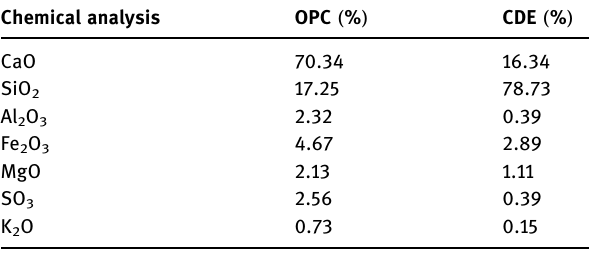
Table 2: Chemical composition of OPC and CDE Chemical analysis